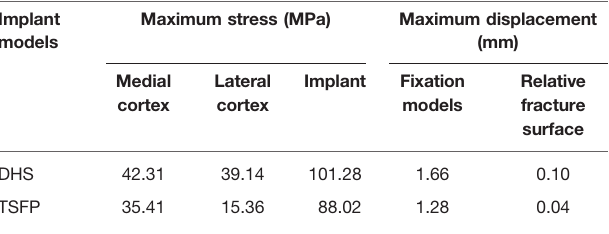
TABLE 4 | The maximum principal stress and minimum principal stress distribution of two implant models for the treatment of unstable and stable intertrochanteric fractures